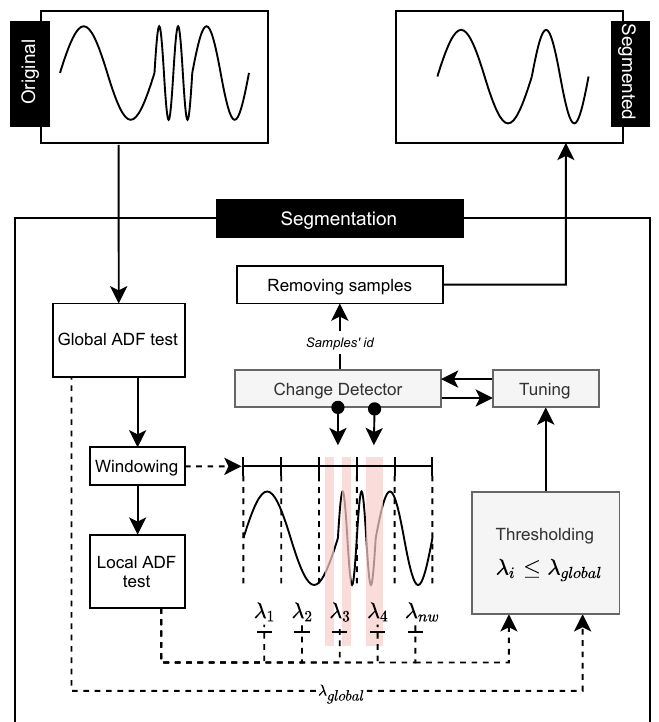
Figure 1. Methodology framework of Change Detector Segmentation.